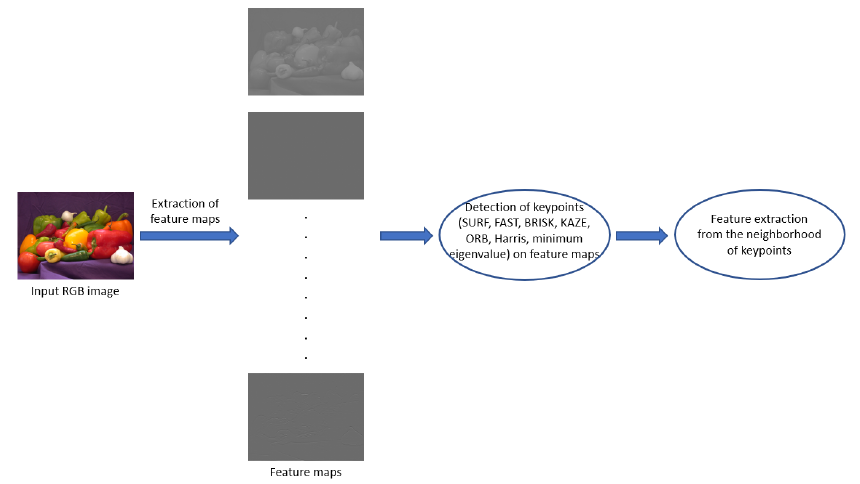
Figure 3. High-level overview of local feature